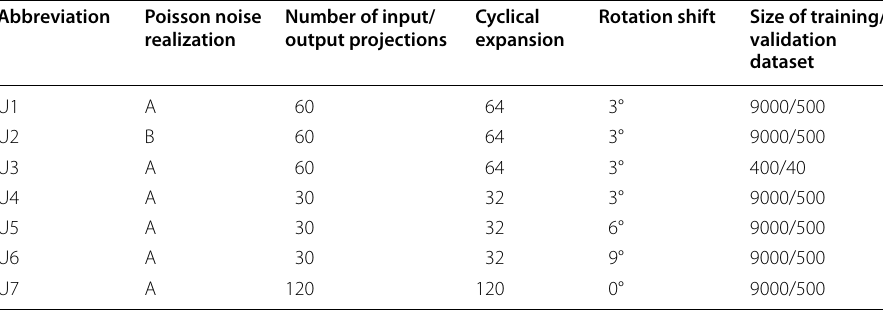
Table 2 Overview over all u‑nets trained in this